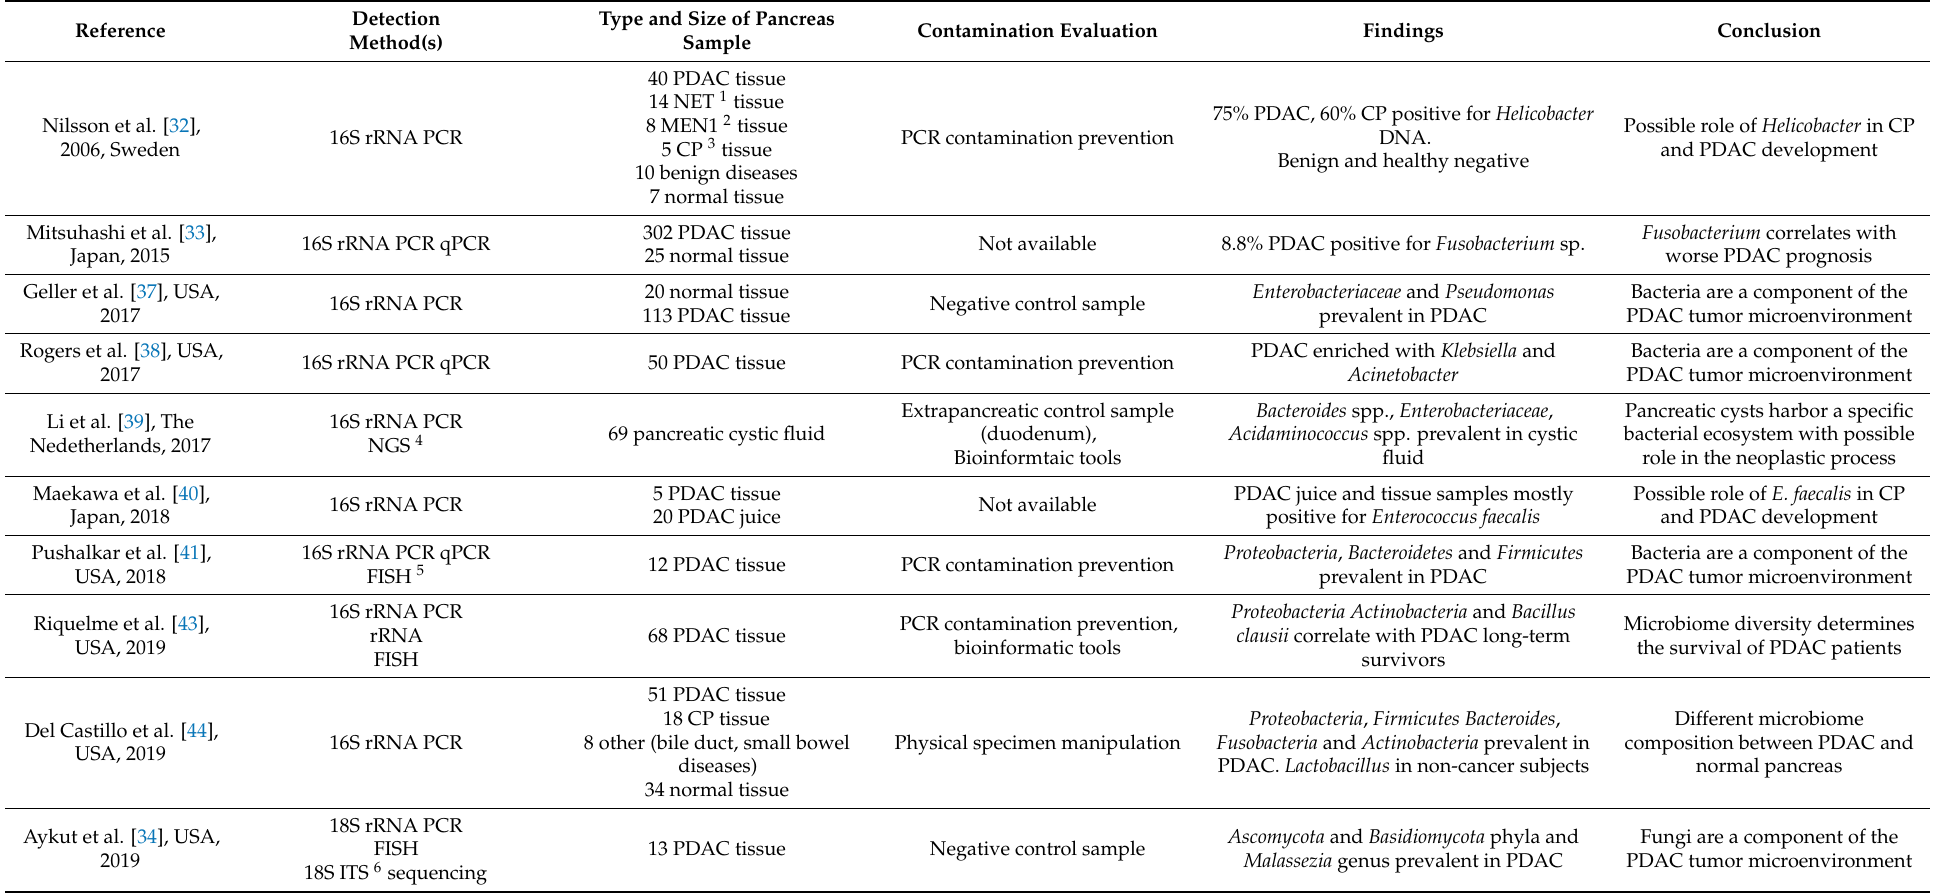
Table 1. Human micro- and mycobiota on pancreatic tissue and fluid